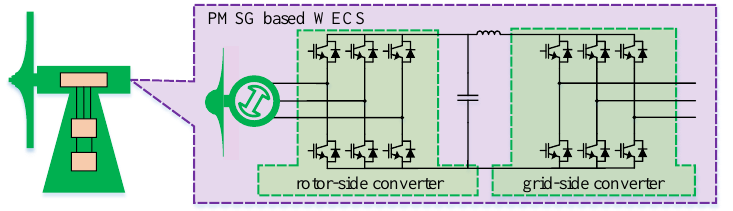
Figure 1. Diagram illustration of the typical PMSG-based wind energy conversion system.